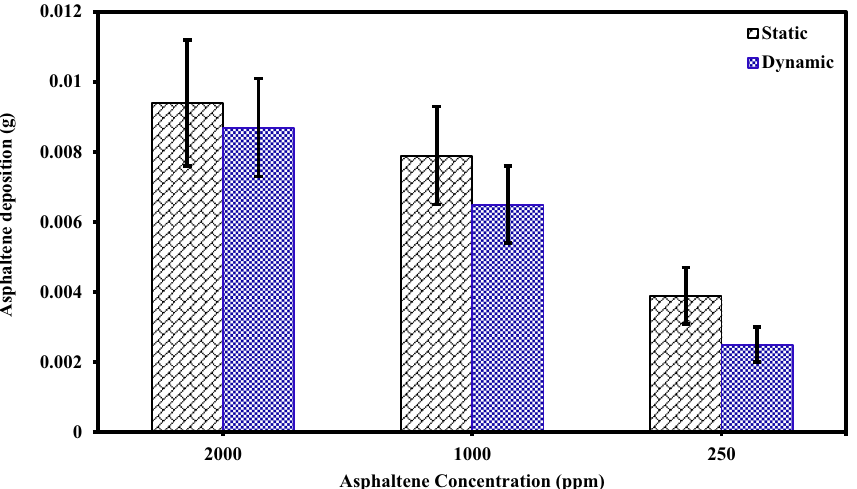
Figure 6. The effect of asphaltene concentration on asphaltene deposition for PTFE coating in static and dynamic states at ambient pressure and temperature.